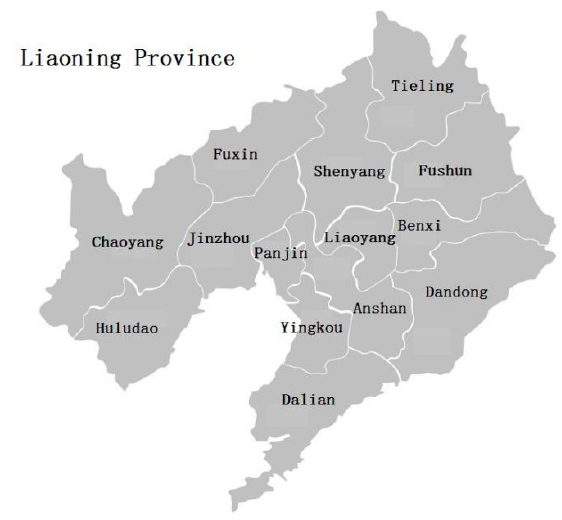
Figure 5. The sampling regions in Liaoning Province.